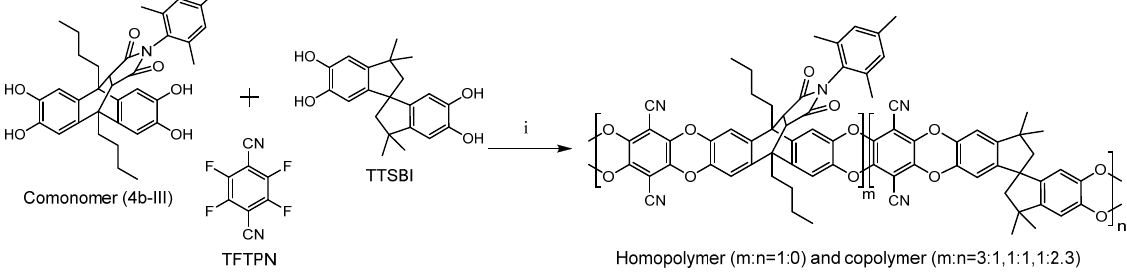
Figure 3. Synthesis of the homopolymer and copolymer of 4b-III (i = K 2 CO 3 , DMAc, DEB, 150 °C, 30 min).